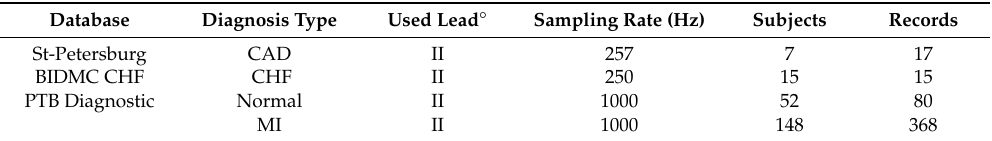
Table 2. Summary of data used in this paper.